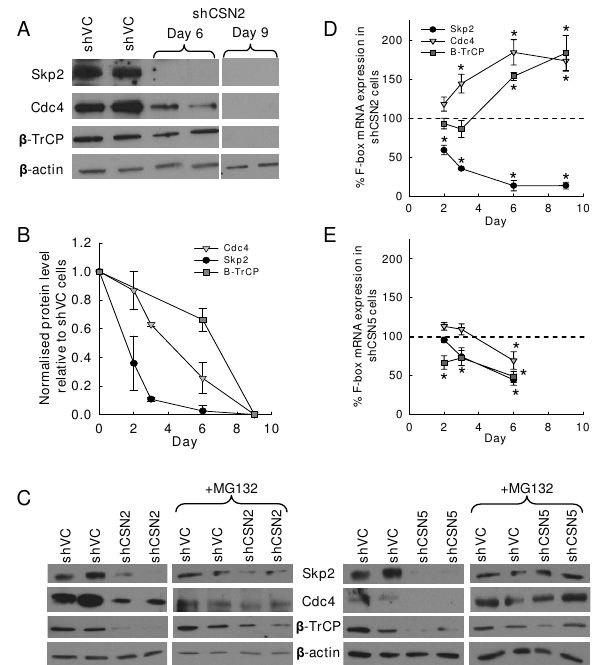
Figure 2 Loss of CSN2 and CSN5 results in sequential loss of F-box proteins . K562 cells were transiently co-transfected with HKK plasmid together with either shVC, shCSN2 or shCSN5 plasmid. HKK positive cells were sorted 24 hours post-transfection and cells re-cultured. (A) shVC and shCSN2 cells were harvested day 6 and 9 post transfection and the level of Skp2, Cdc4, β -TrCP and β -actin protein determined by western blot. (B) The level of Skp2, Cdc4 and β -TrCP proteins (normalised for loading using β -actin) in shCSN2 at each time point was normalised to expression in shVC cells and the data plotted as the mean ± s.e.m. (C) shVC, shCSN2 and shCSN5 cells were treated with DMSO (control) or the proteasome inhibitor MG132 (10 μ M) for the final 18 hours of culturing and the level of Skp-2, Cdc4, β - TrCP and β -actin protein determined by western blot. (D, E) The level of Skp2, Cdc4 and β -TrCP mRNA in shCSN2 (D) and shCSN5 (E) cells was determined at each time point post transfection relative to expression in vector control scram- ble cells by QRT-PCR. Data shown is the mean ± s.e.m of n = 3 transfections. * indicates a significant difference to vector controls with a p value of less than